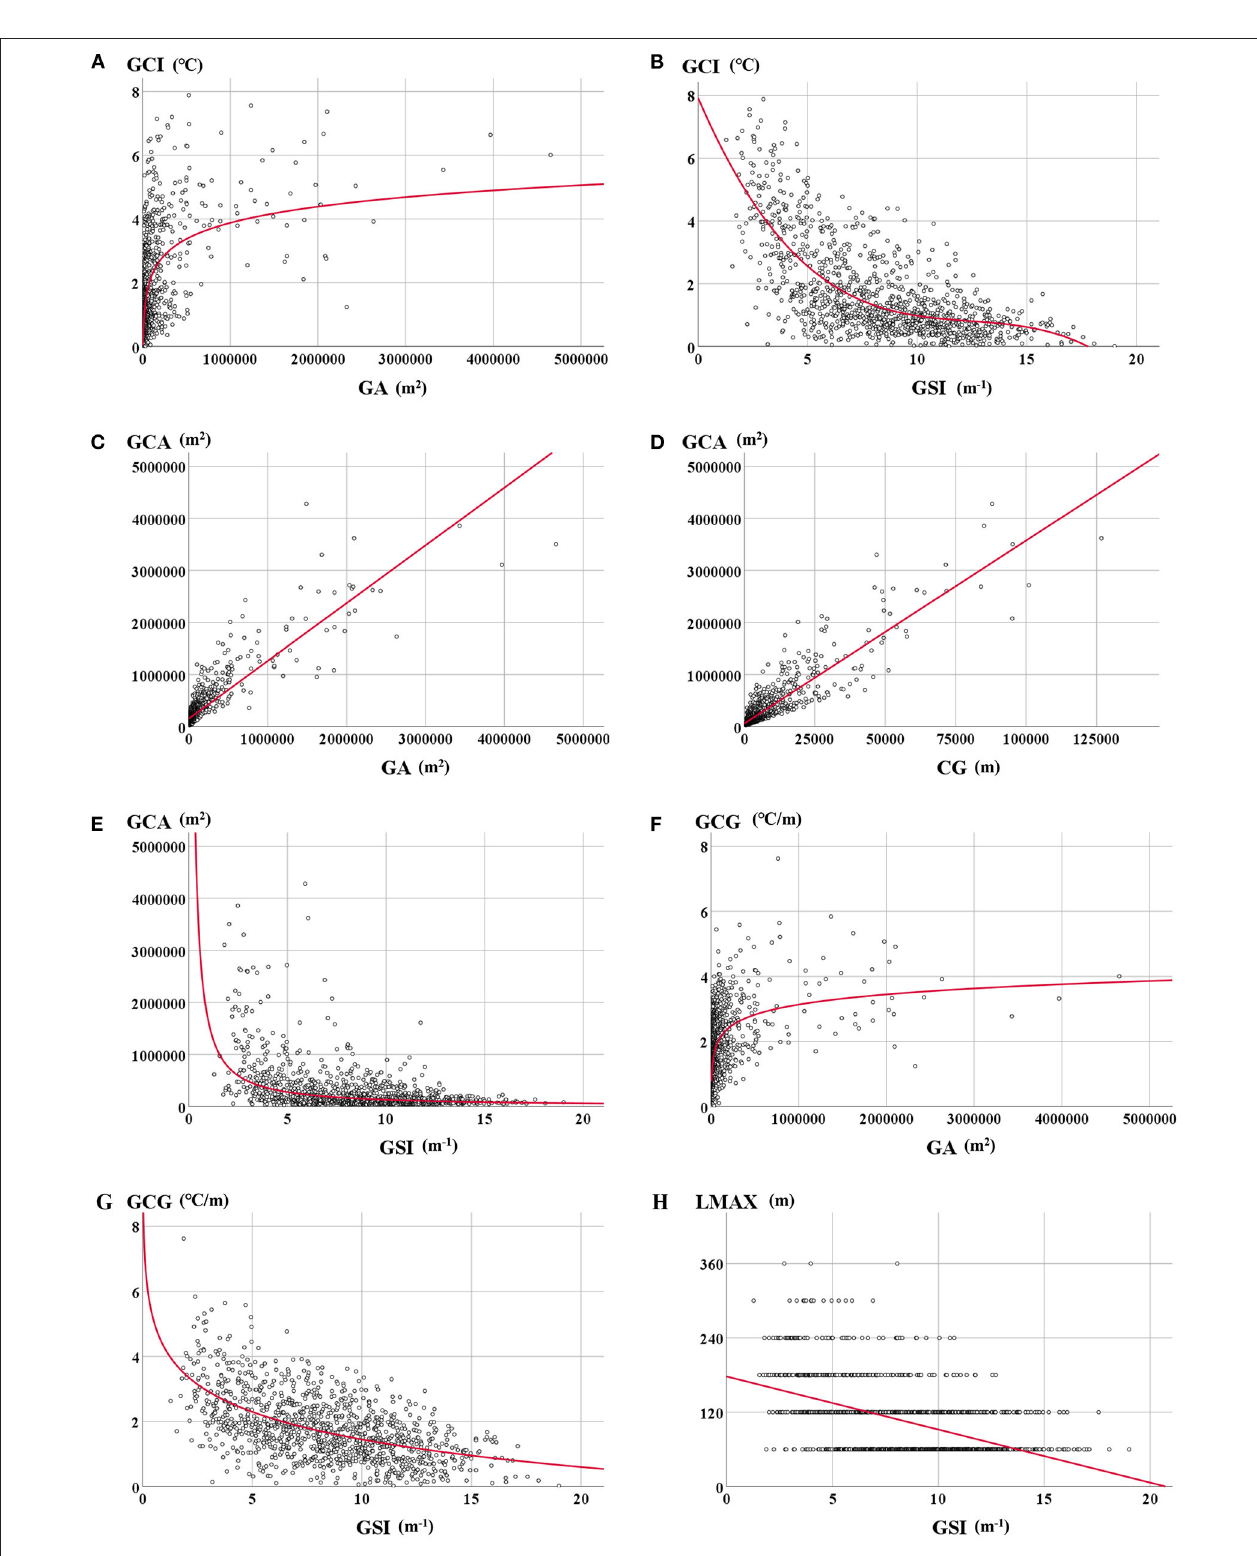
FIGURE 5 | Relationship between dependent (GCI) and independent [GA: (A) , GSI: (B) ], relationship between dependent (GCA) and independent [GA: (C) , C G : (D) , GSI: (E) ], relationship between dependent (GCG) and independent [GA: (F) , GSI: (G) ], relationship between dependent (L MAX ) and independent [GSI: (H) ]. The regression line using the ordinary least squares method is presented in red. The regression models were selected among linear, logarithmic, and power functions with the largest R 2 value.